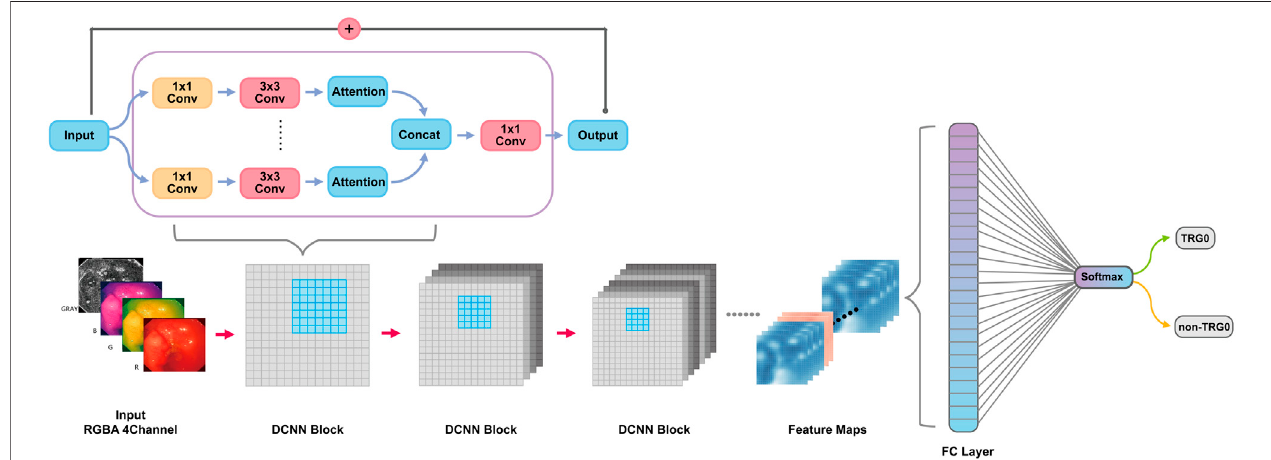
FIGURE 1 | The key architecture diagram of the DCNN model. DCNN, deep convolutional neural network.